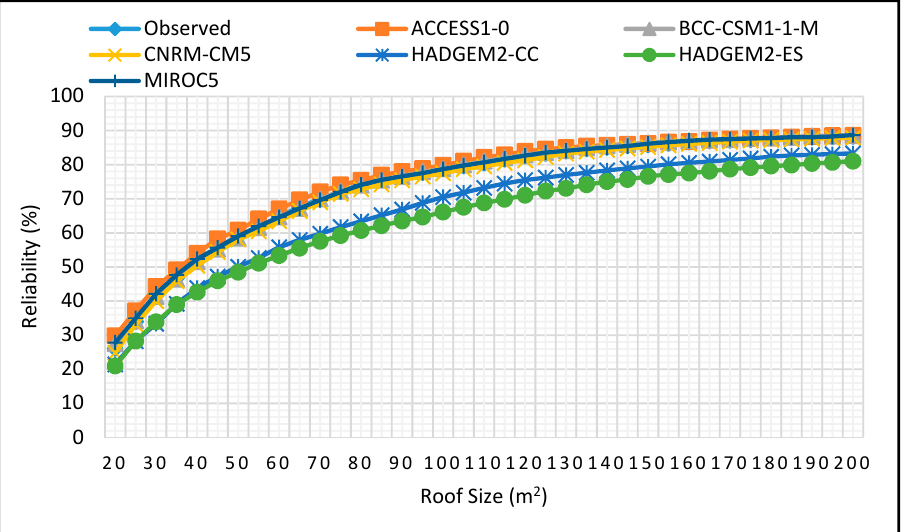
Figure 12. Reliability projections for DJF season for 2 m 3 tank size for 2025–2055.